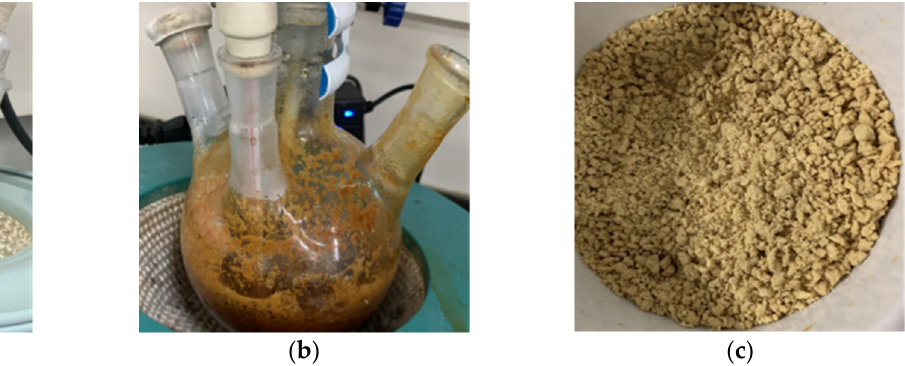
Figure 2. Sulfonation synthesis process 1. ( a ) Propylene diester alginate; ( b ) propylene diester algi ‐ nate add formamide; ( c ) after dropping chlorosulfonic acid.